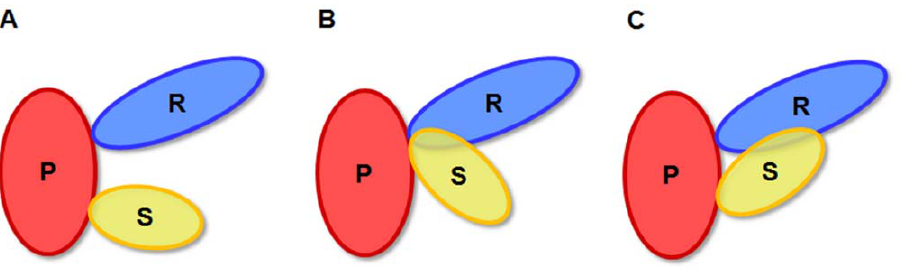
Figure 1. Schematic overview of structurally possible interactions between three proteins P, R and S. (A) The three proteins interact simultaneously via two distinct binding interfaces at P. (B) R and S cannot interact with P at the same time due to the overlapping binding interface at P. (C) Although R and S interact with P via separate binding interfaces, their simultaneous interaction with P is prevented by a collision of R and S.